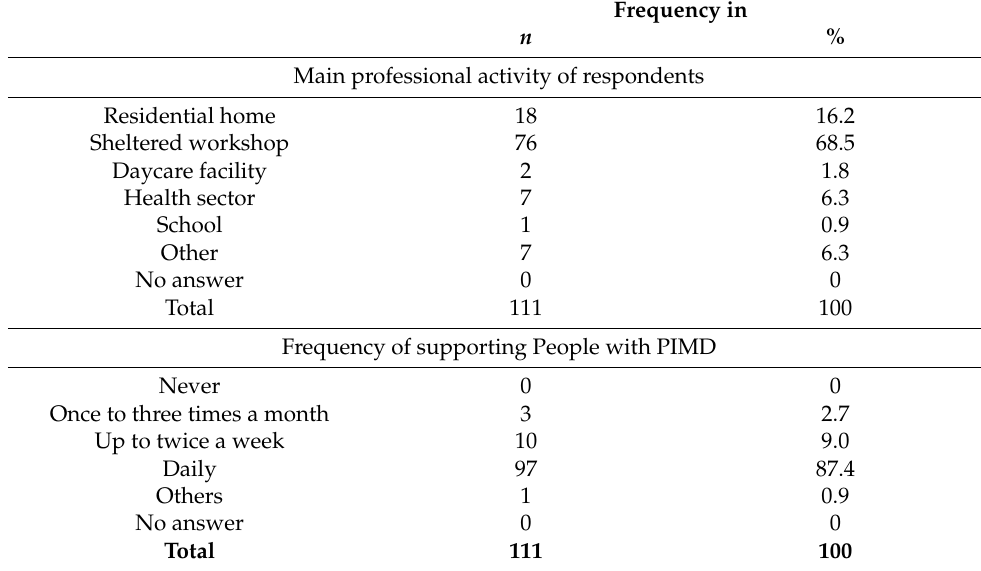
Table 1. Sample of the online